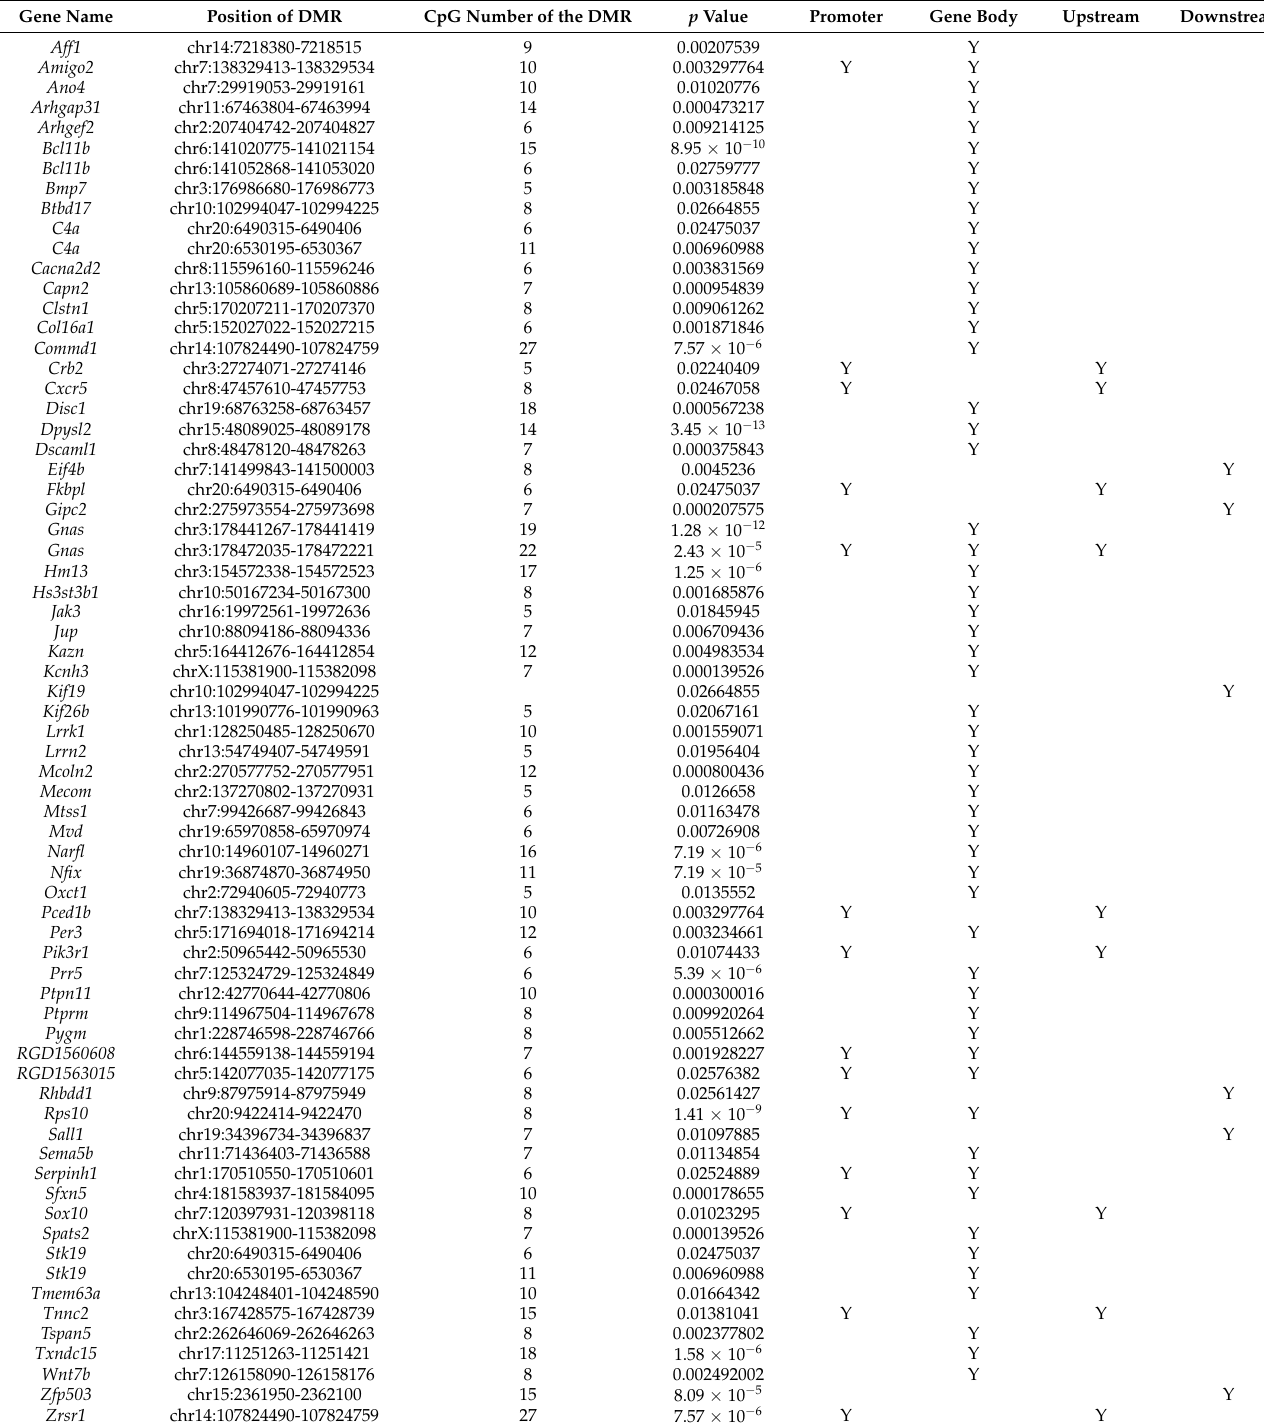
Table 3. The distribution of